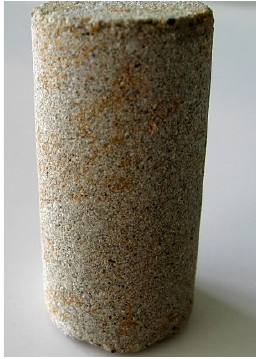
Figure 2. A core cut from a sandstone sample [27].